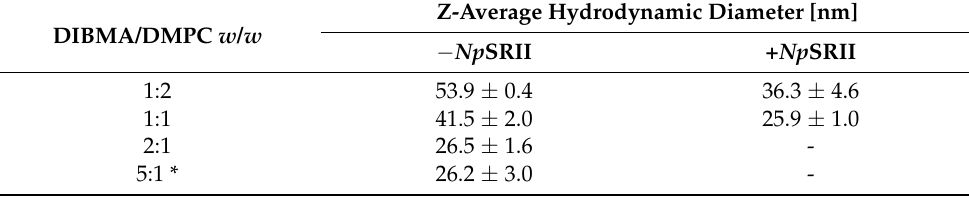
Figure 1. Characterization of lipid bilayer nanoparticles formed by diisobutylene/maleic acid (DIBMA). ( a ) Scheme showing the preparation of empty and protein-filled DIBMA lipid particles (DIBMALPs) and their biophysical characterization. ( b ) Representative dynamic light scattering (DLS) intensity-weighted size distributions of empty (broken lines) and Np SRII containing (continuous lines) DIBMALPs formed upon addition of 4% ( m / v ) DIBMA at a DIBMA/2-dimyristoyl- sn -glycero-3-phosphocholine (DMPC) weight ratio of 1:2 (green traces), 1:1 (red traces) and 2:1 (black traces) to DMPC liposomes. All intensities were normalized to that of the black trace. Table 1. z-Average diameter, z, of DIBMALPs determined by DLS at different DMPC/DIBMA ratios for preparations in absence and presence of Np SRII (average values of at least two repetitions). * In addition, the values from [45] are given for comparison, and were determined at a concentration (DIBMA:lipid) of 5:1.